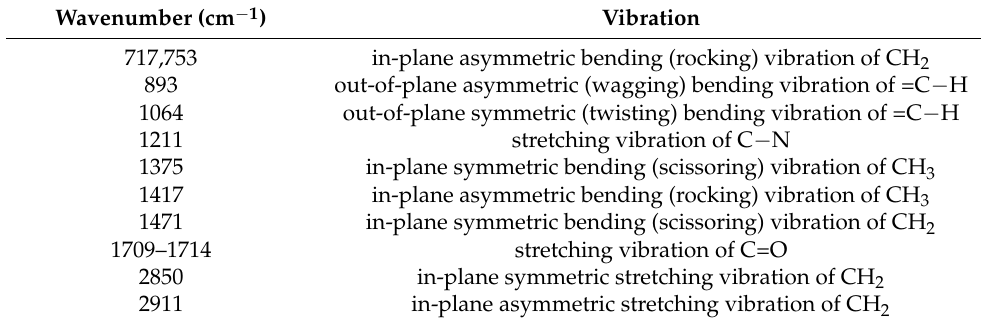
Table 1. Secondary nucleation and growth parameters from spherulitic growth of PK crystals.